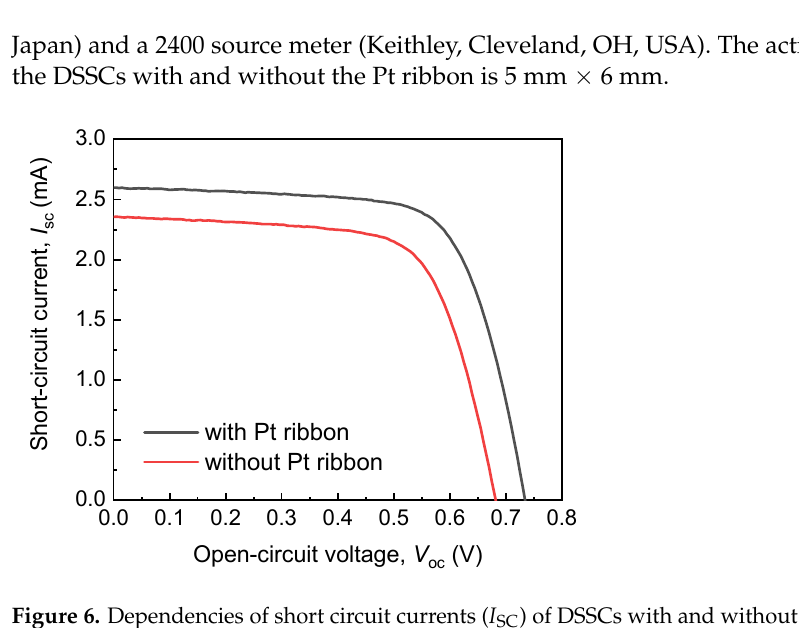
Figure 6. Dependencies of short circuit currents ( I SC ) of DSSCs with and without a Pt ribbon on open circuit voltages ( V OC ).